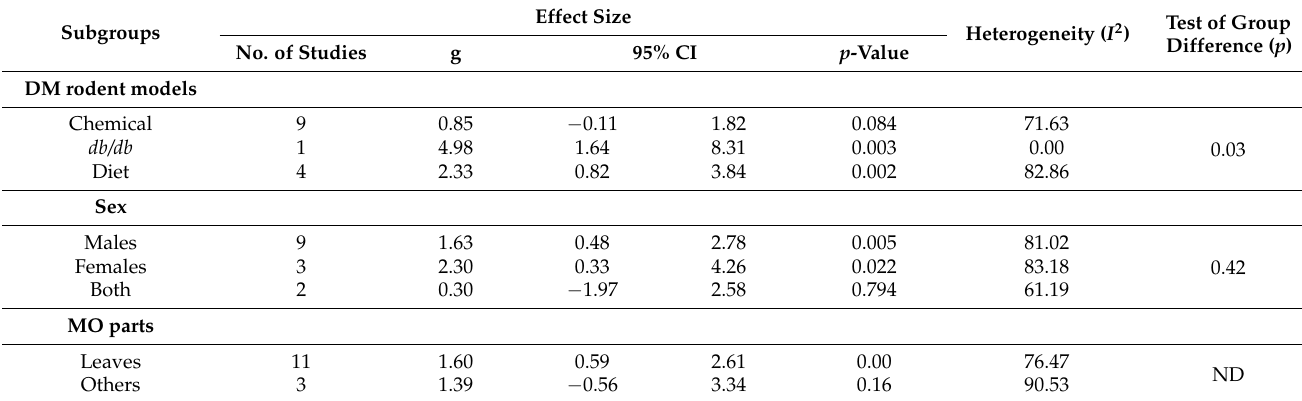
Table 4. Subgroup analyses of HDL-C levels.